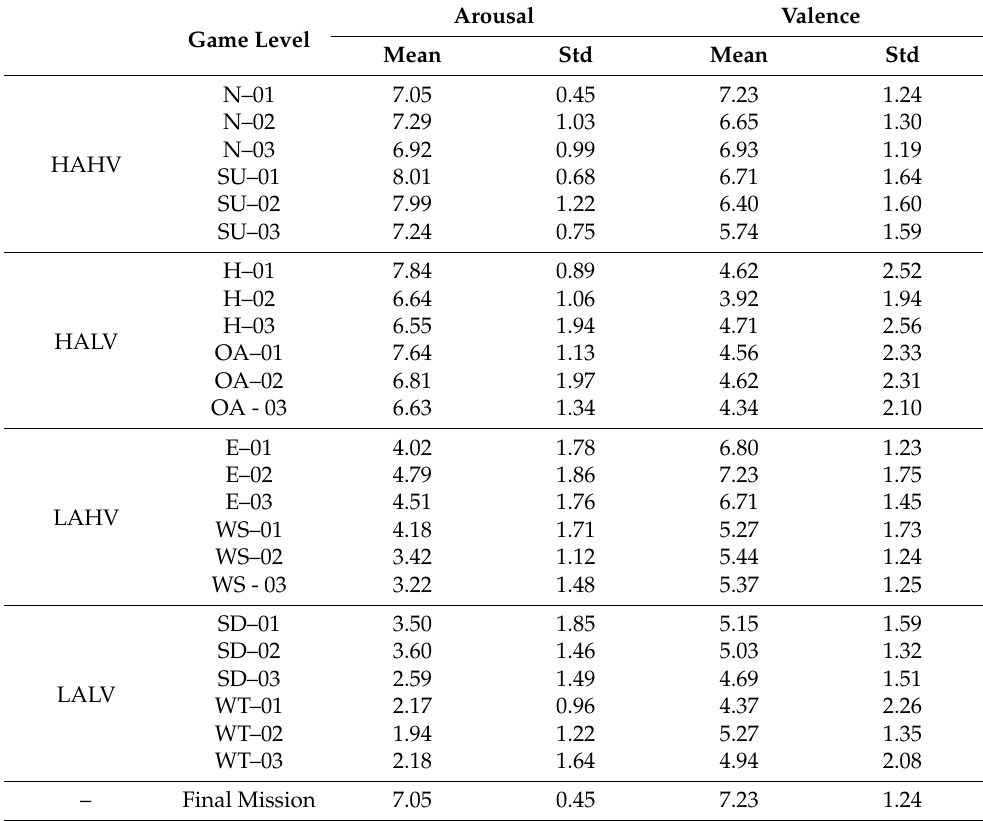
Table 3. Arousal and valence means and standard deviation for the 24 game